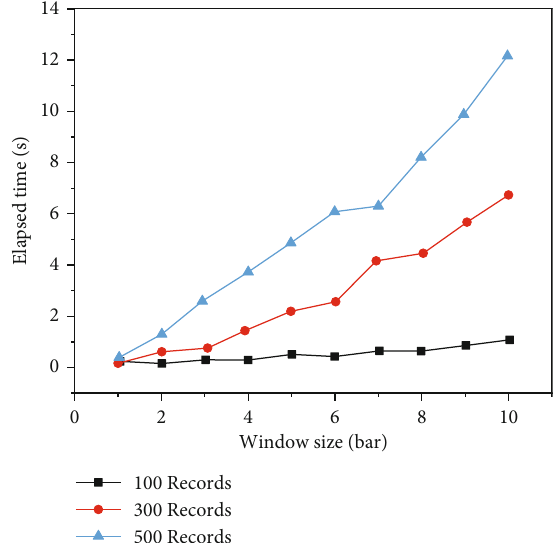
Figure 7: Time comparison